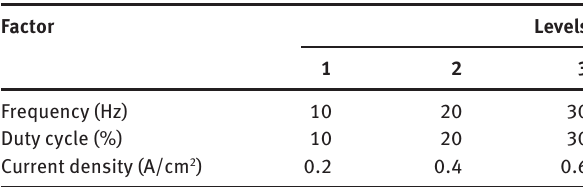
Figure 2 S/N graph for microhardness of Ni-nano-Al coatings.